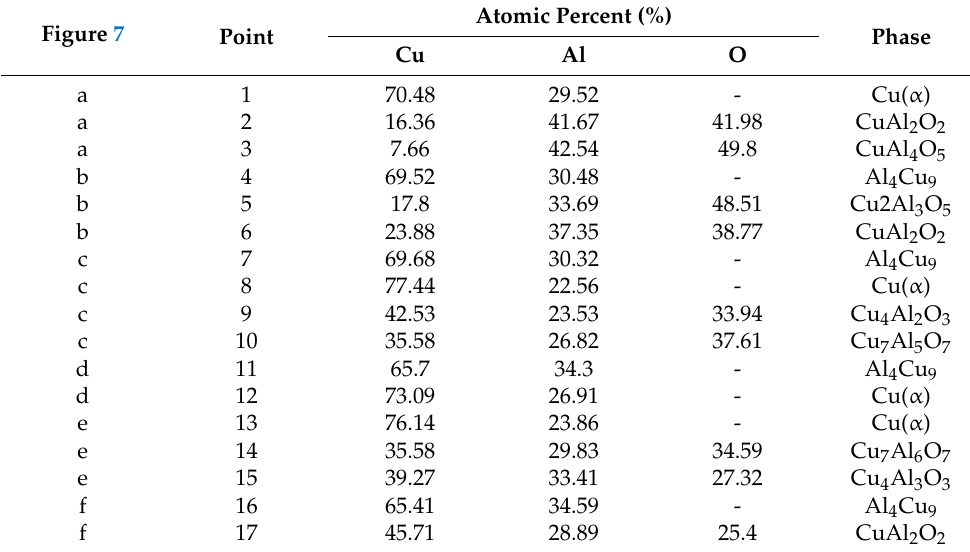
Table 3. EDS analysis of corresponding samples of Figure 7.